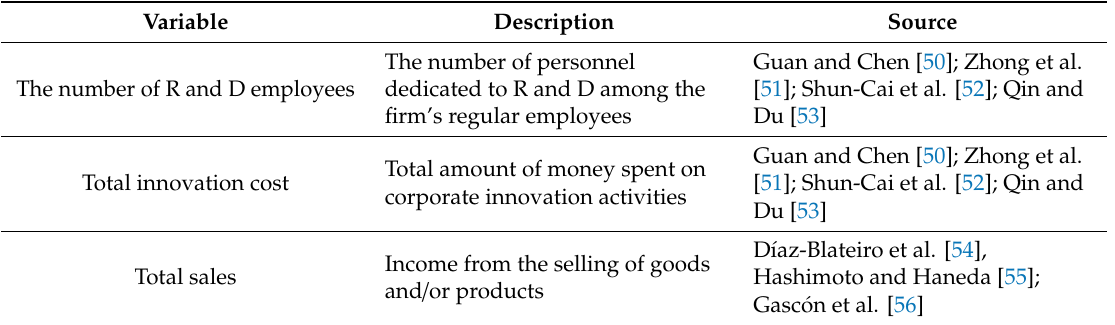
Table 2. Variables selection.